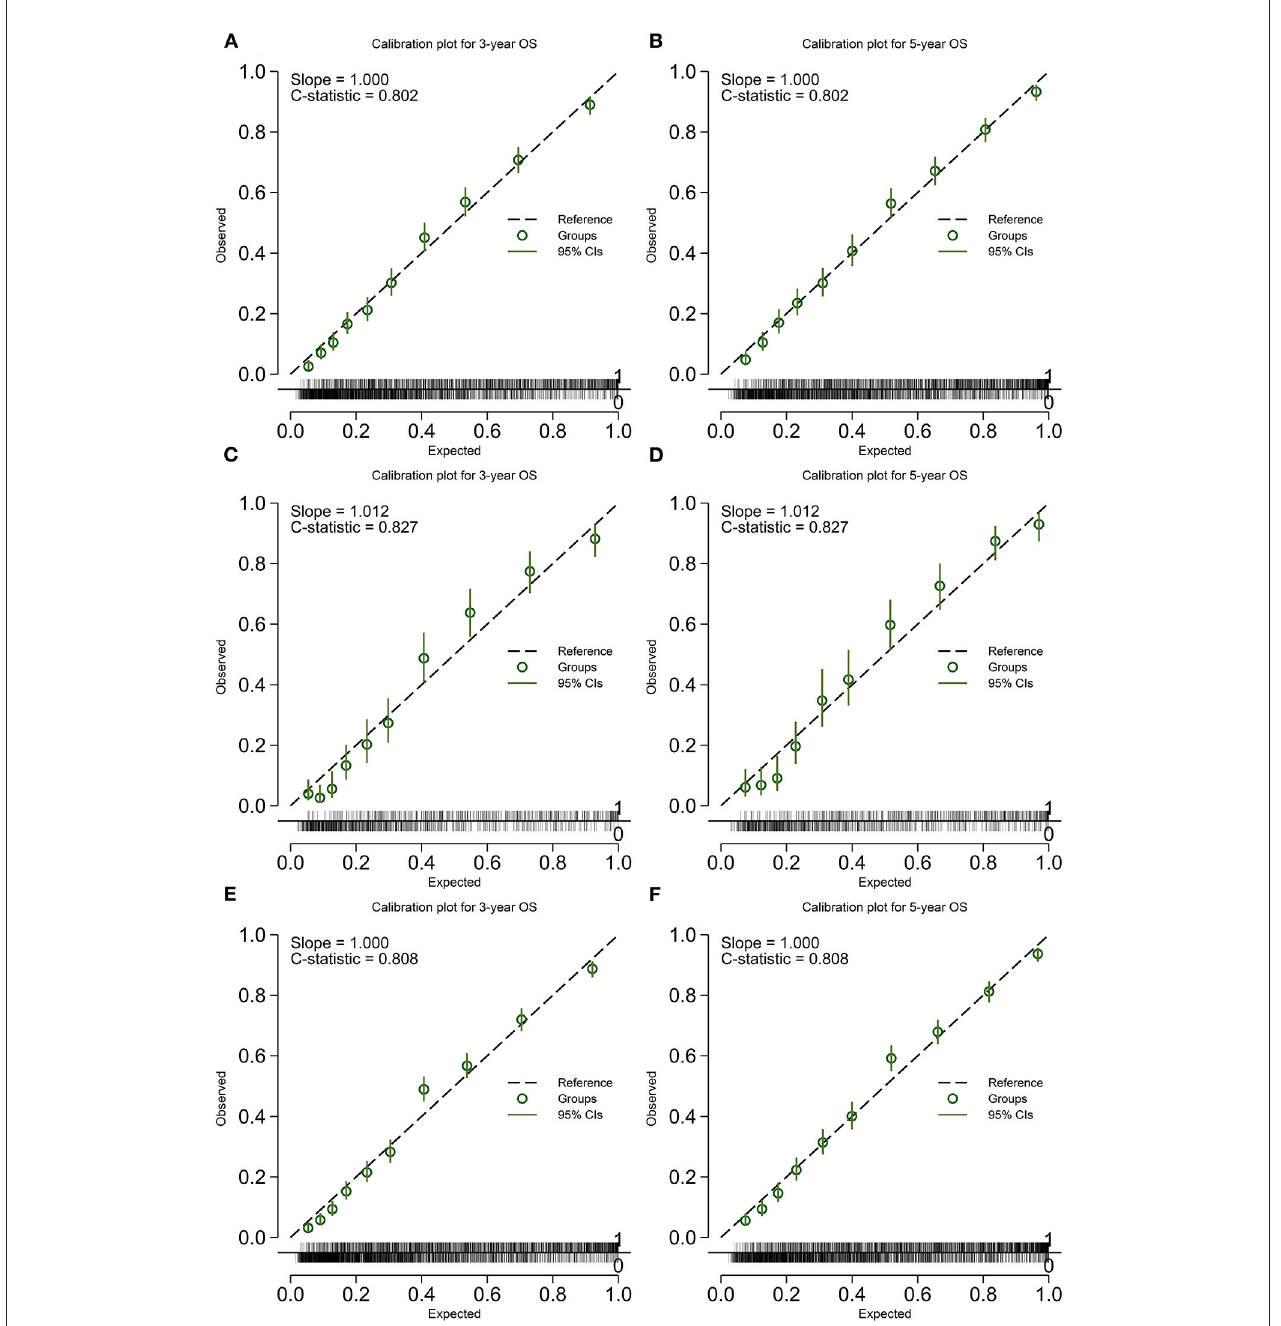
FIGURE 4 | Calibration plot of the model predicting OS. (A) 3-years OS in the training cohort; (B) 5-years OS in the training cohort; (C) 3-years OS in the validation cohort; (D) 5-years OS in the validation cohort; (E) 3-years OS in the overall cohort; and (F) 5-years OS in the overall cohort. OS, overall survival.